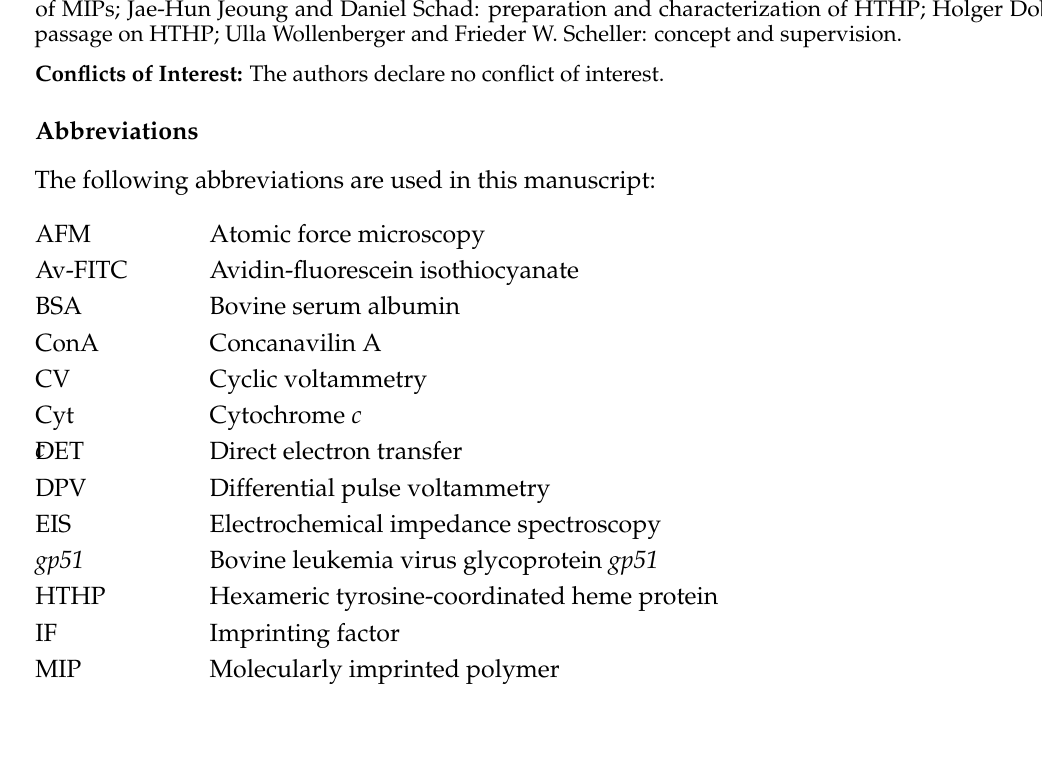
Figure S3: CVs of the MIP covered Au electrode under semi-anaerobic condition in 10 mM K 2 HPO 4 –KH 2 PO 4 , pH 8, 400 mV/s. ( a ) after electropolymerization; ( b ) after removal of HTHP; ( c ) after rebinding in 1.3 mM HTHP solution for 1 h, Figure S4: Normalized current signal from SWVs of ( a ) MUA/Au (set to 1) and ( b ) MIPs incubated in 32.5 µ M HTHP solution for 1 h 2.5 mM K 2 HPO 4 –KH 2 PO 4 at pH